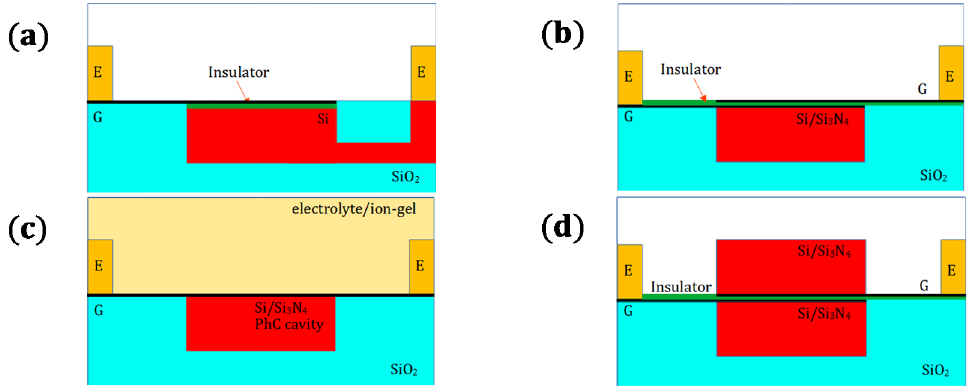
Figure 6. Sketches of the location of graphene electrodes: ( a ) Graphene-Insulator-Waveguide (GIW), ( b ) Graphene-Insulator-Graphene (GIG), ( c ) Electrolyte/ion-gel-Graphene-Waveguide+PhC Cavity (EGWC) and ( d ) Graphene-Insulator-Graphene inside waveguide (GEin). (G–Graphene electrode and E–electrode).